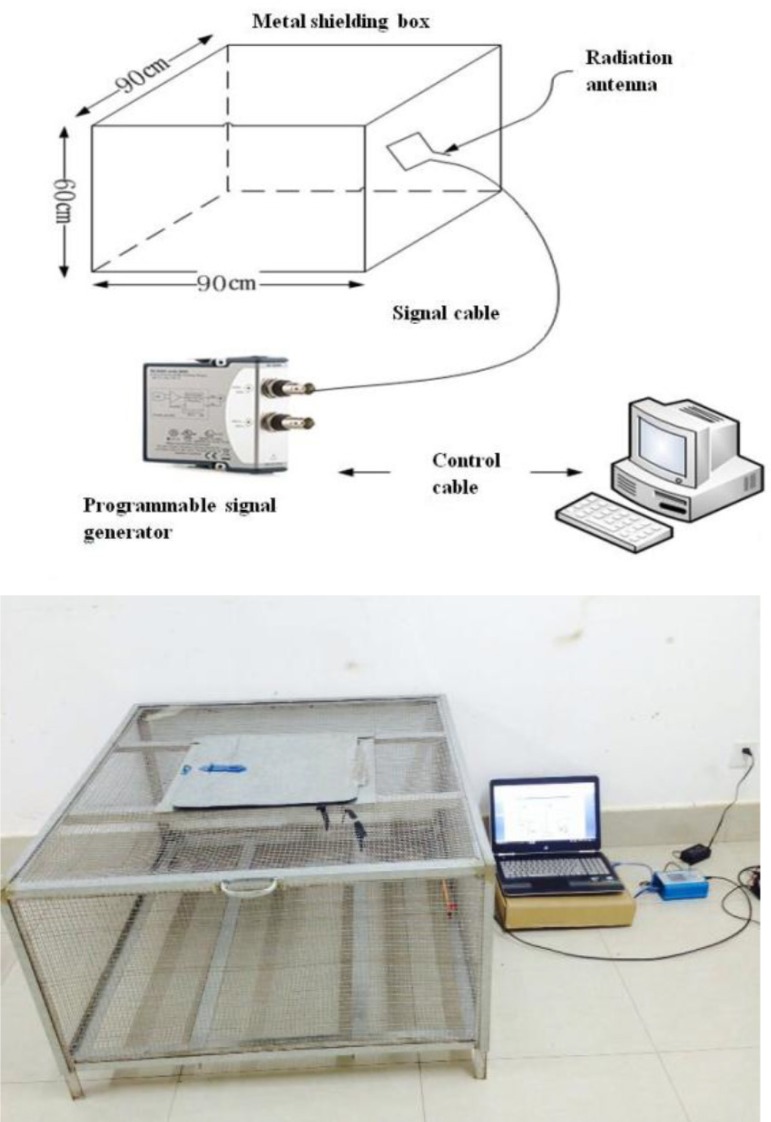
The structure drawing of geomagnetic experimental platform.